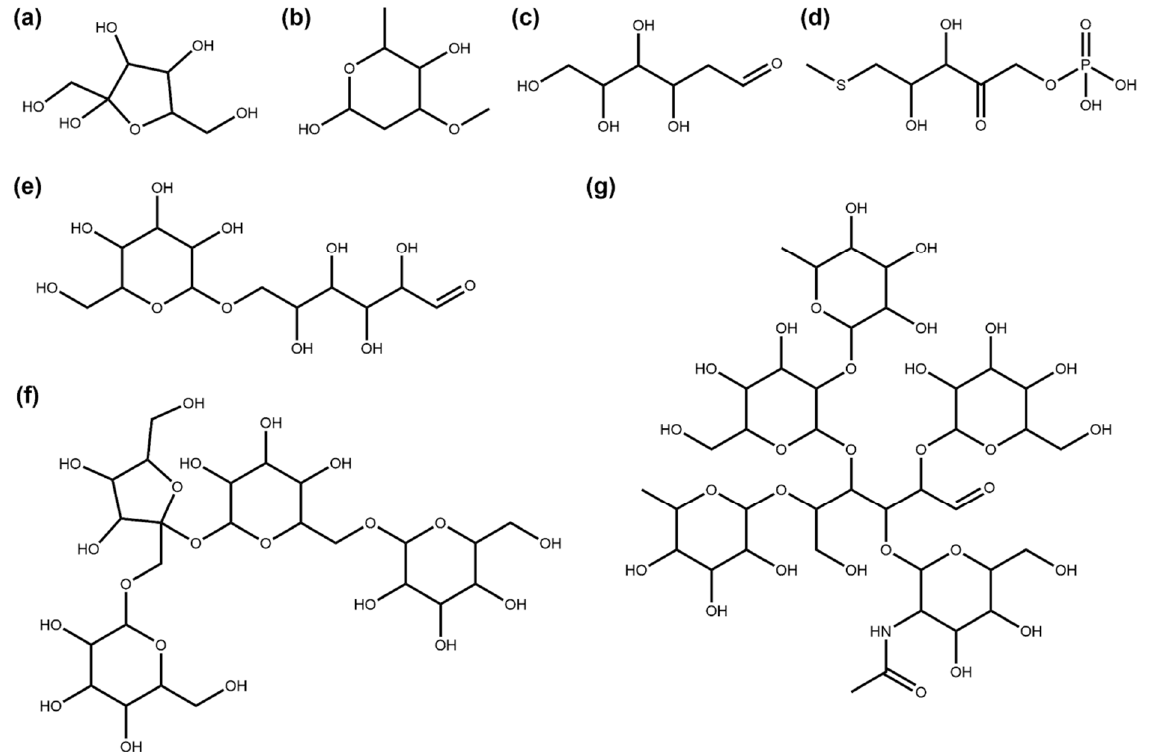
Figure 4. Examples of NPs that consist only of glycosidic moieties with side chains smaller than five heavy atoms. ( a ) Fructose (COCONUT ID CNP0232181), a commonly known monosaccharide. ( b ) Oleandrose (CNP0112845), a monosaccharide detected by the SRU despite its methyl and methoxy substituents and one deoxidised ring position. ( c ) 2-Deoxy-D-Glucose (CNP0019597), a linear monosaccharide. ( d ) S-Methyl-5-Thio-D-Ribulose-1-Phosphate (CNP0066170), a highly derivatised ribulose structure that the SRU still detects as a single linear sugar. ( e ) Isomaltose (CNP0226411), an isomer of maltose represented here with one glucose unit in open-chain formation which leads to recognition by the SRU as a polymer of one circular and one linear sugar moiety. ( f ) Lychnose (CNP0261531), a tetrasaccharide found in plants [28]. ( g ) Lacto-N-difucohexaose (CNP0084068), an oligosaccharide made up of five circular sugars and a central linear sugar that is found in human milk [29].